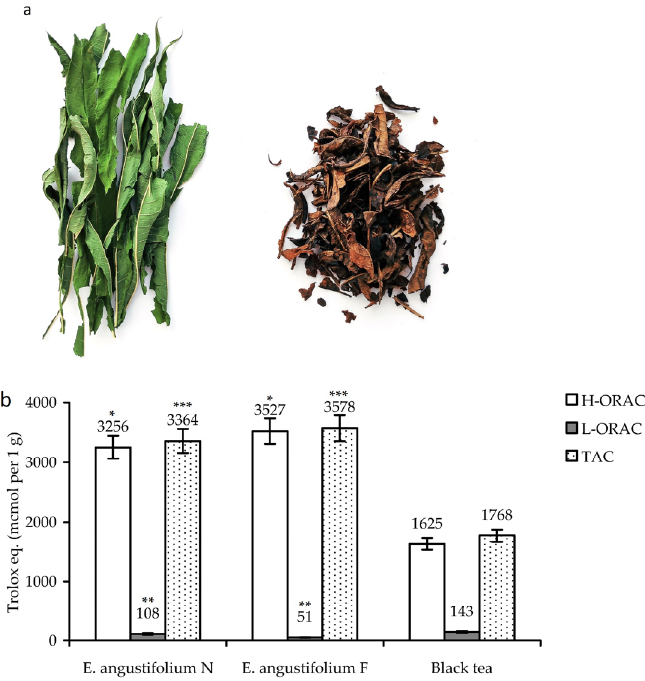
Figure 1. ( a ) Dried leaves of Epilobium angustifolium before (left) and after fermentation (right). ( b ). Hydrophilic (H-ORAC) and lipophilic (L-ORAC) antioxidant capacity and total antioxidant capacity (TAC; as Trolox equivalents, μ mol per gram) of E. angustifolium leaves before ( E. angustifolium N) and after fermentation ( E. angustifolium F) in comparison with black tea (Lipton ® tea). The results show the mean ± S.D. of five experiments. * p < 0.01 vs. black tea H-ORAC group; ** p < 0.01 vs. black tea L-ORAC group; and *** p < 0.01 vs. black tea TAC group.